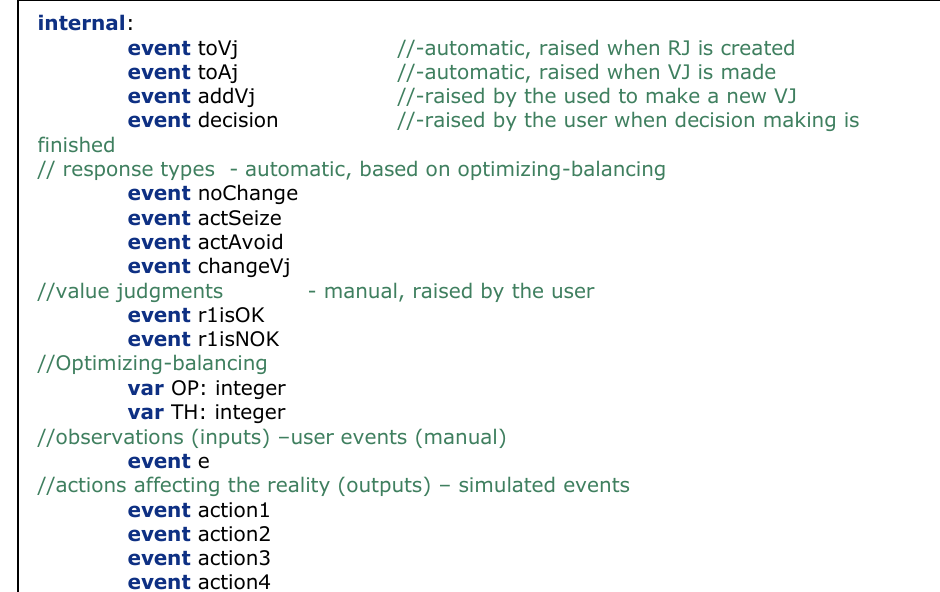
Figure 7. Events and variables used in the Appreciation